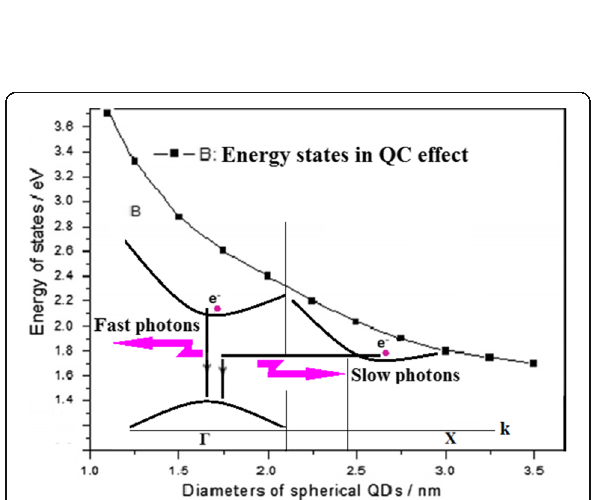
Fig. 7 The emission model depiction from the analysis of the PL decay spectra on Si NCs with various diameters, in which the direct-gap emission relates to the faster photons on the smaller NCs (diameters <2 nm), and the indirect-gap emission relates to the slower photons (involving phonon assistance process) on the larger NCs (diameters >2.5